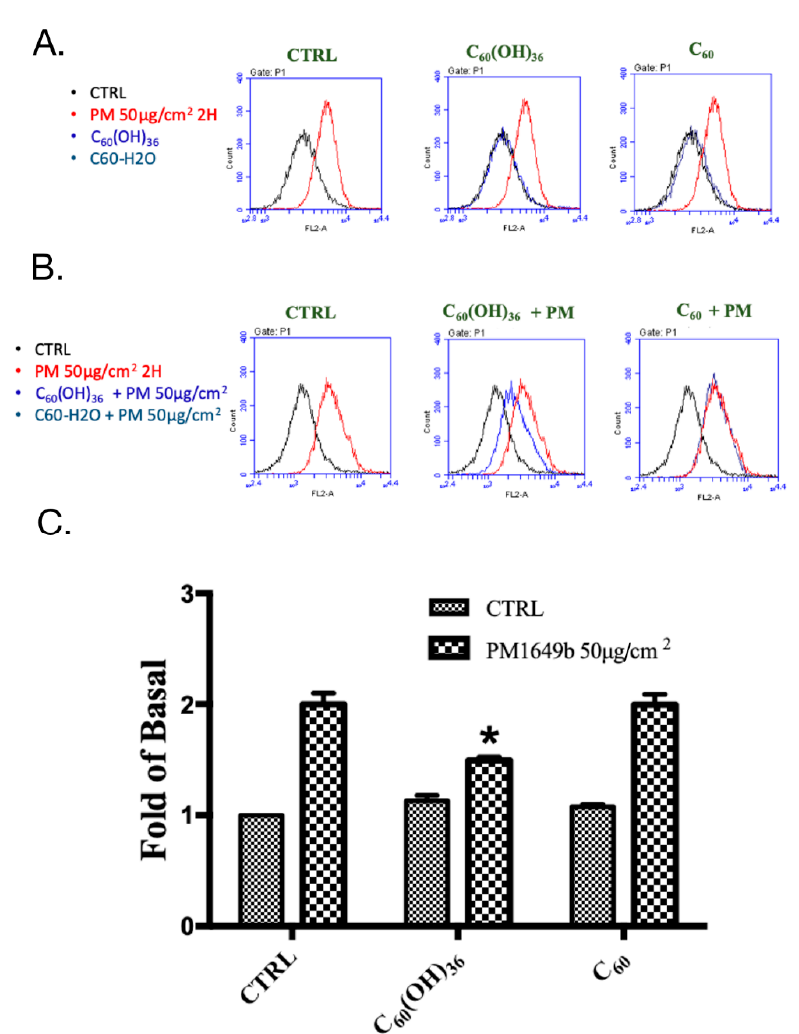
Figure 5. Effect of fullerenol C 60 (OH) 36 , fullerene C 60 , and PM on mitochondrial reactive oxygen species (ROS) production (determined by flow cytometry with MitoSOX staining) in HaCaT cells. ( A ) Raw flow cytometry data obtained along with MitoSOX staining data in cells treated with fullerenol C 60 (OH) 36 , fullerene C 60 , or PM alone. ( B ) Raw flow cytometry data obtained along with MitoSOX staining data in cells that received fullerenol C 60 (OH) 36 , or fullerene C 60 (1 μ M) for 1 h, after which PM (SRM 1649b, 50 μ g/cm 2 ) was administered for another 2 h. ( C ) The bar graph illustrates the cumulative counts of MitoSOX flow cytometry results. All bar graph data were collected from at least three individual experiments and expressed as mean ± SEM values. * p < 0.05, as compared to the values for the PM exposure group.